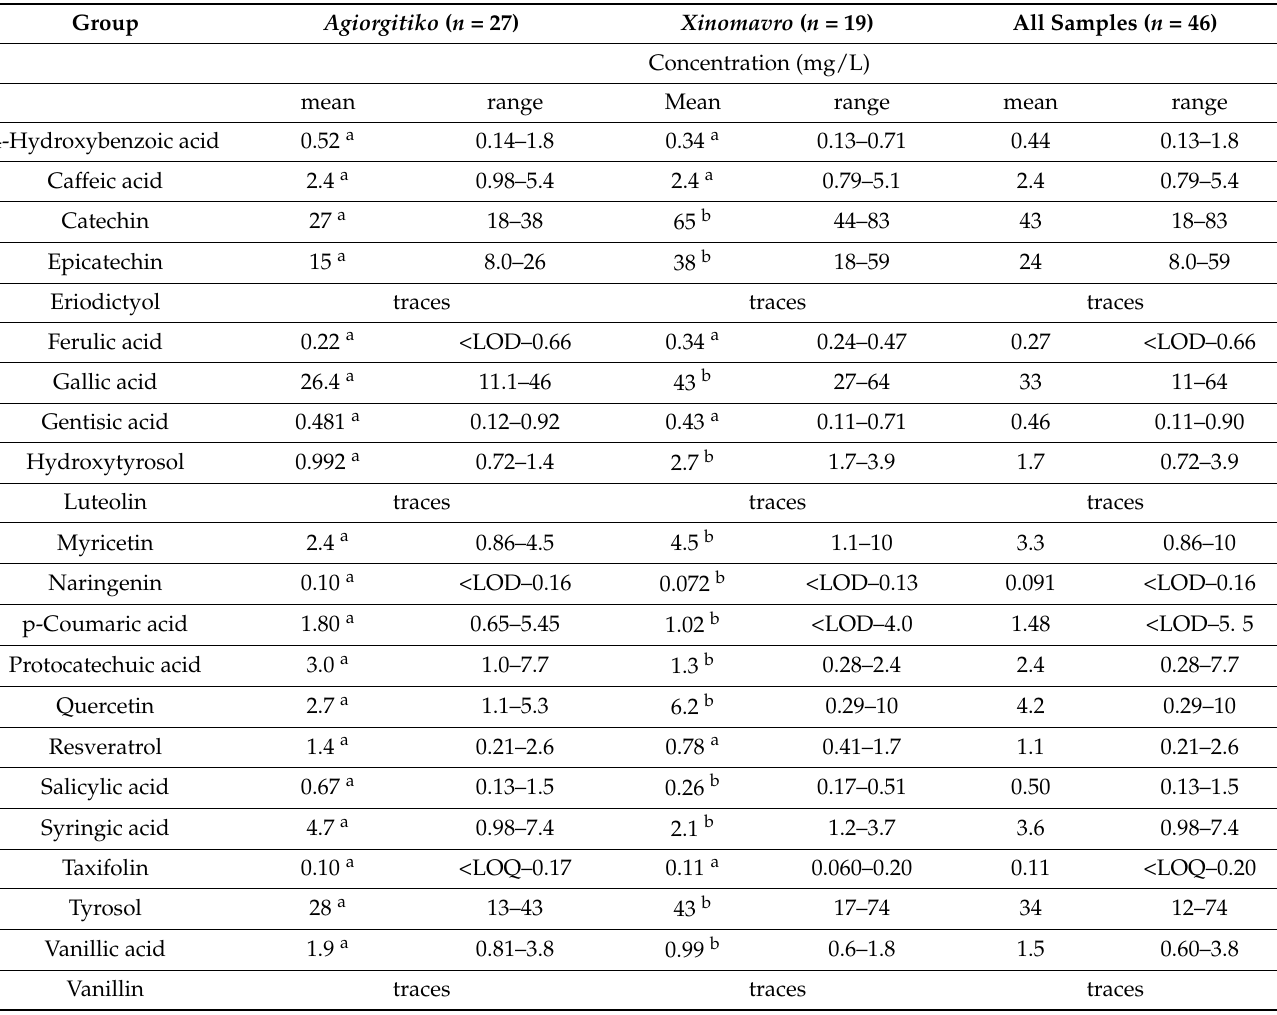
Table 1. Concentrations of target compounds detected in the red wine